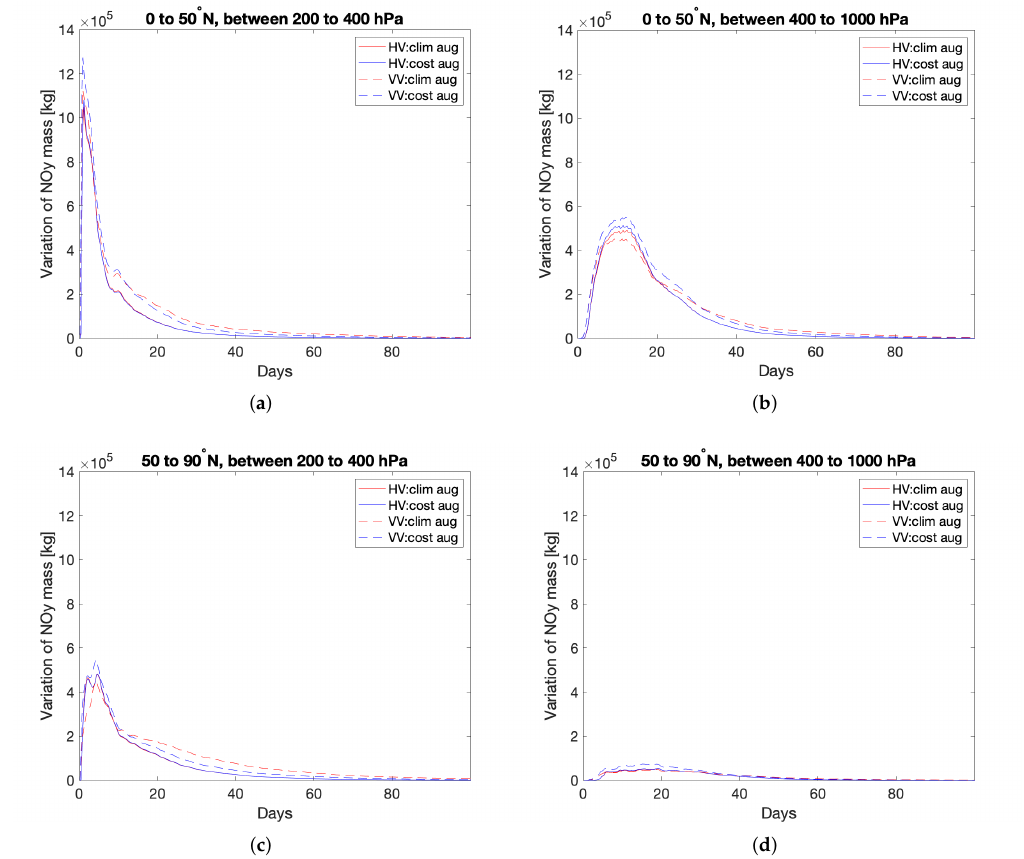
Figure 19. NO y atf mass [kg(N)] time series in specific regions from chemistry–climate simulations starting on 1 August 2016. The red and blue lines indicate the climate-optimised and cost-optimised cases, respectively, and the panel titles in ( a – d ) indicate the investigated